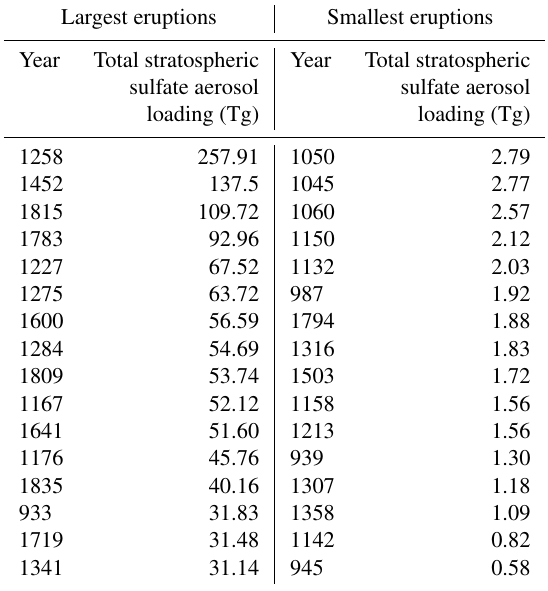
Table A2. Years and total stratospheric sulfate aerosol injection of the 16 largest and 16 smallest volcanic eruptions in 850–1849CE from Gao et al. (2008).